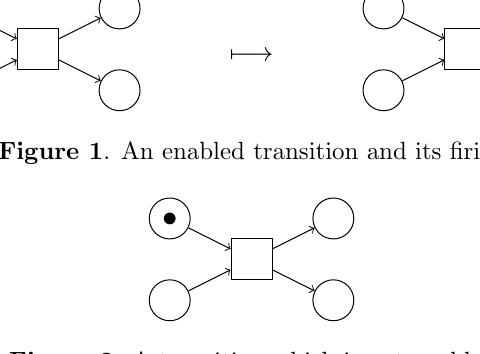
Figure 2 . A transition which is not